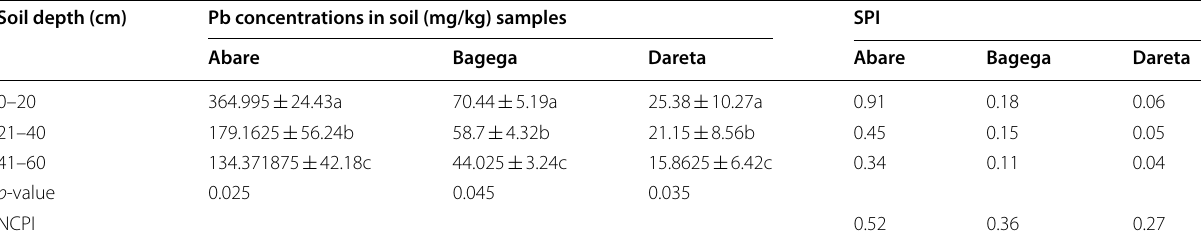
Table 4 Pb concentration (mg/kg), and single pollution index (SPI) and Nemerow composite pollution index (NCPI) of the farmland across the study